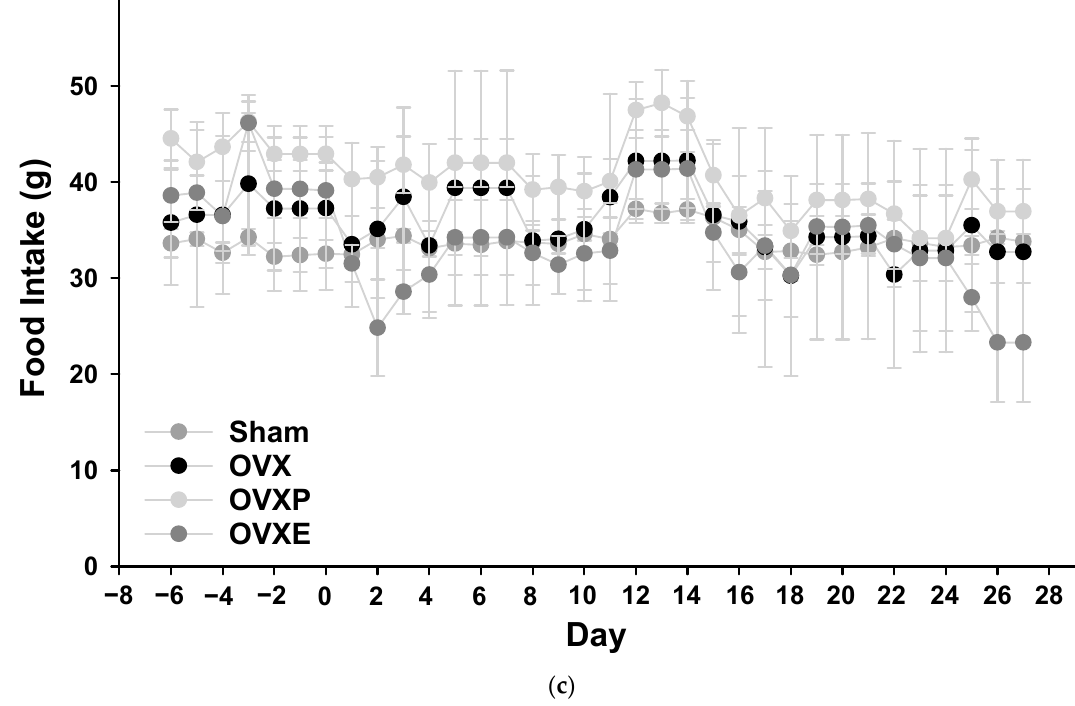
Figure 2. Changes in ( a ) body weight, ( b ) water intake, and ( c ) food intake. There was a significant difference in ( a ) between the sham and the other groups ( p < 0.05) after 4 weeks, but not in ( b ) or ( c ).